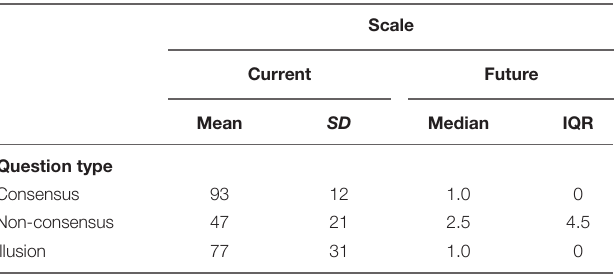
TABLE 1 | Central tendencies and deviations in the answerability judgments for the current and the future answerability